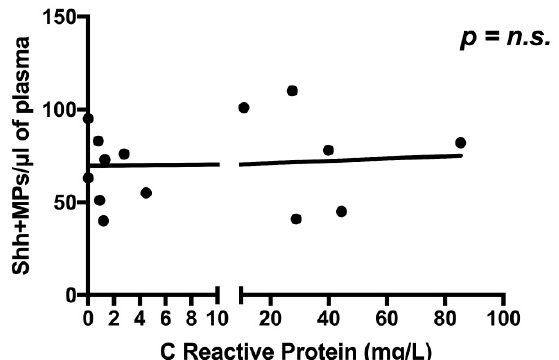
Figure 5. Global number of Shh + MPs according to C Reactive Protein (CRP) levels. Black horizontal line indicates the interpolate curve.